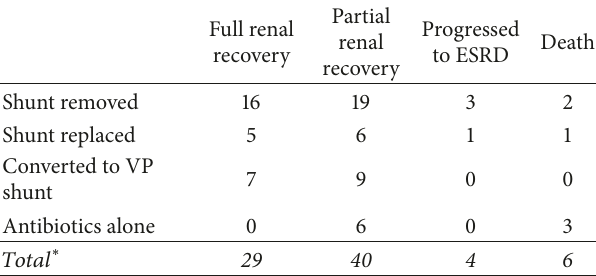
Table 9). Our brief analysis did not account for other